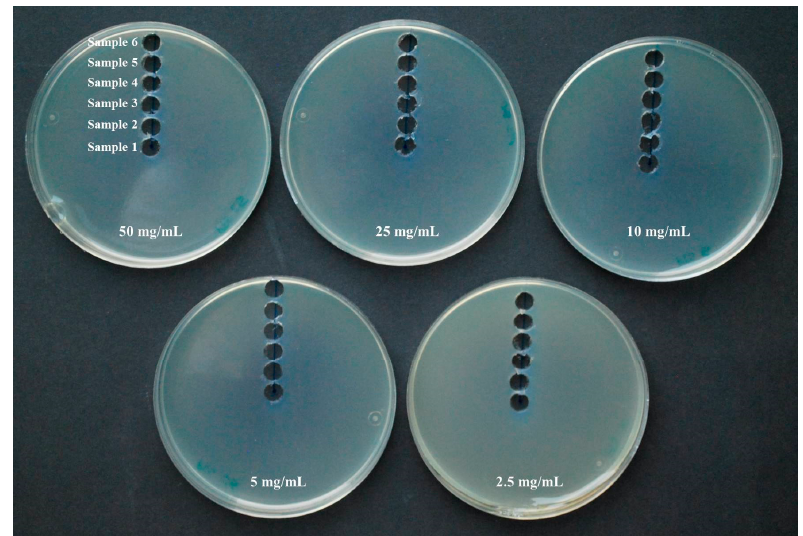
Figure 4. Procedure for obtaining samples from the Mueller–Hinton agar growth medium to es- tablish the concentration of PTS and PTSO reached on it via the gas phase of both compounds by HPLC-UV. For each organosulfur compound and concentration, after incubation for 24 h at 36 ± 1 °C, samples with a diameter of 7.5 mm were extracted from the center of the plate to the periphery in order to determine the concentration of PTS and PTSO reached on the agar as a consequence of its evaporation.